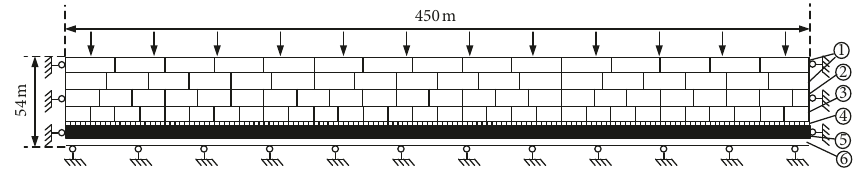
Figure 7: The computational model: ① sandstone; ② coarse sandstone; ③ sandstone; ④ mudstone; ⑤ coal; ⑥ Table 1: Physical and mechanical parameters of the materials.